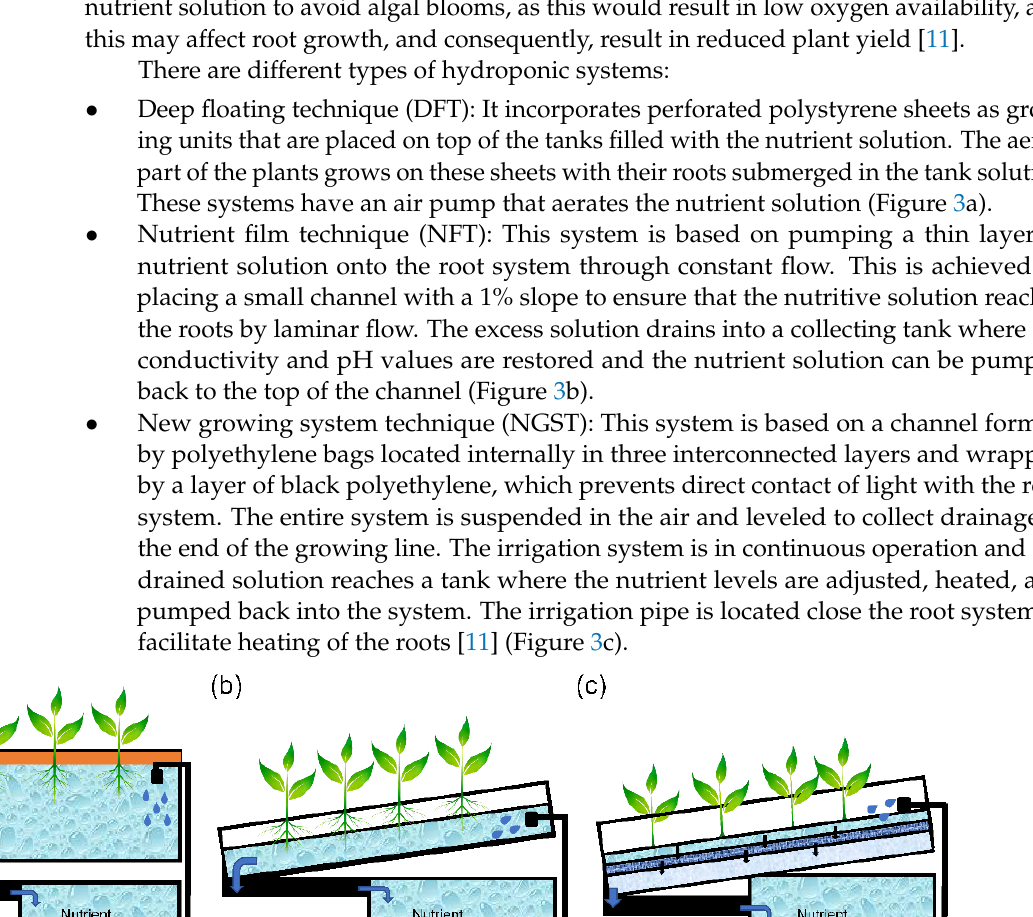
Figure 2. Aeroponic cultivation systems. ( a ) Spray column system, ( b ) Schwalbach system, and ( c ) Aero-Gro system.